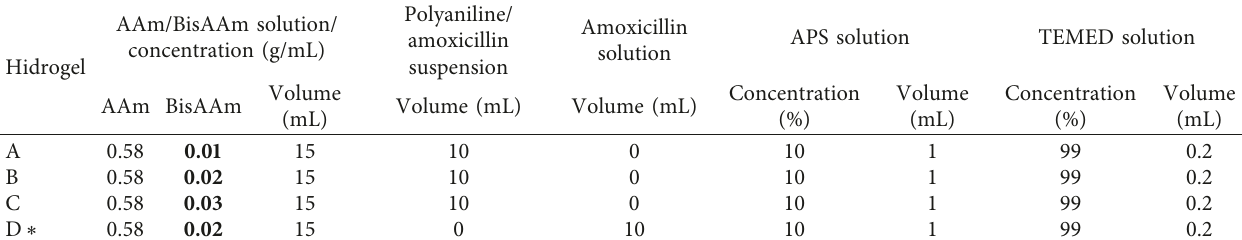
Table 2: Concentrations and volumes for amoxicillin composite hydrogels used in release versus buffer solutions.